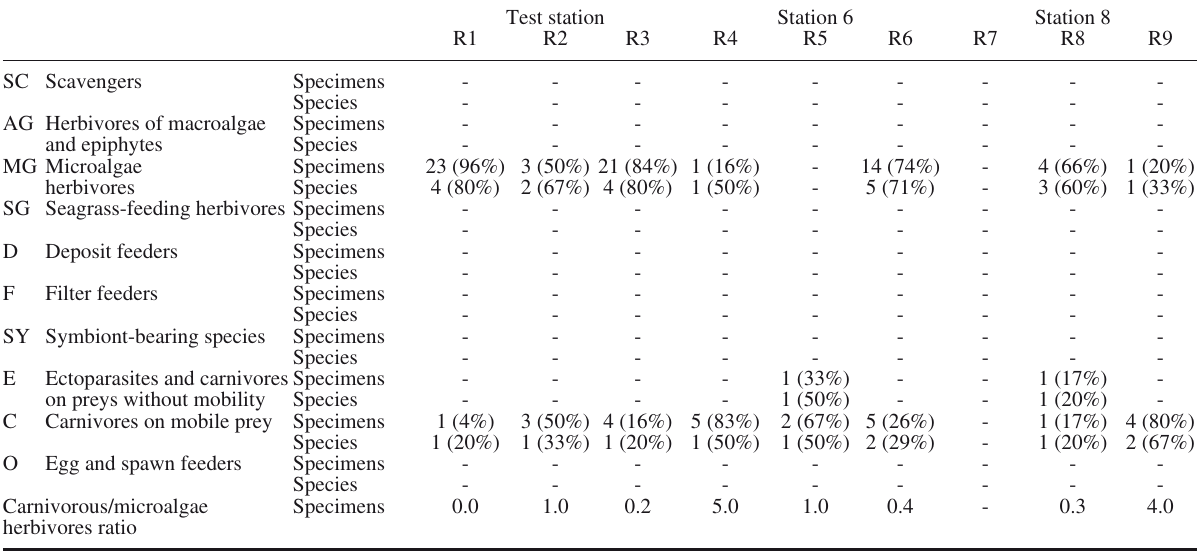
Table 3. – Number of specimens and species and their percentage for each feeding guild for the Posidonia oceanica leaves.